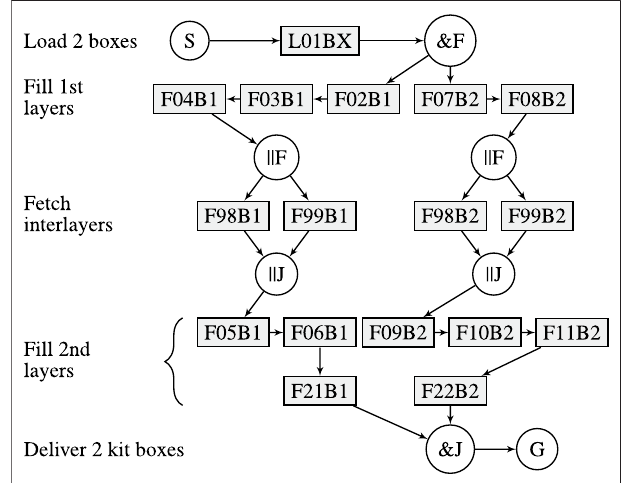
FIGURE 5 | RTSG representation of Scenario B.